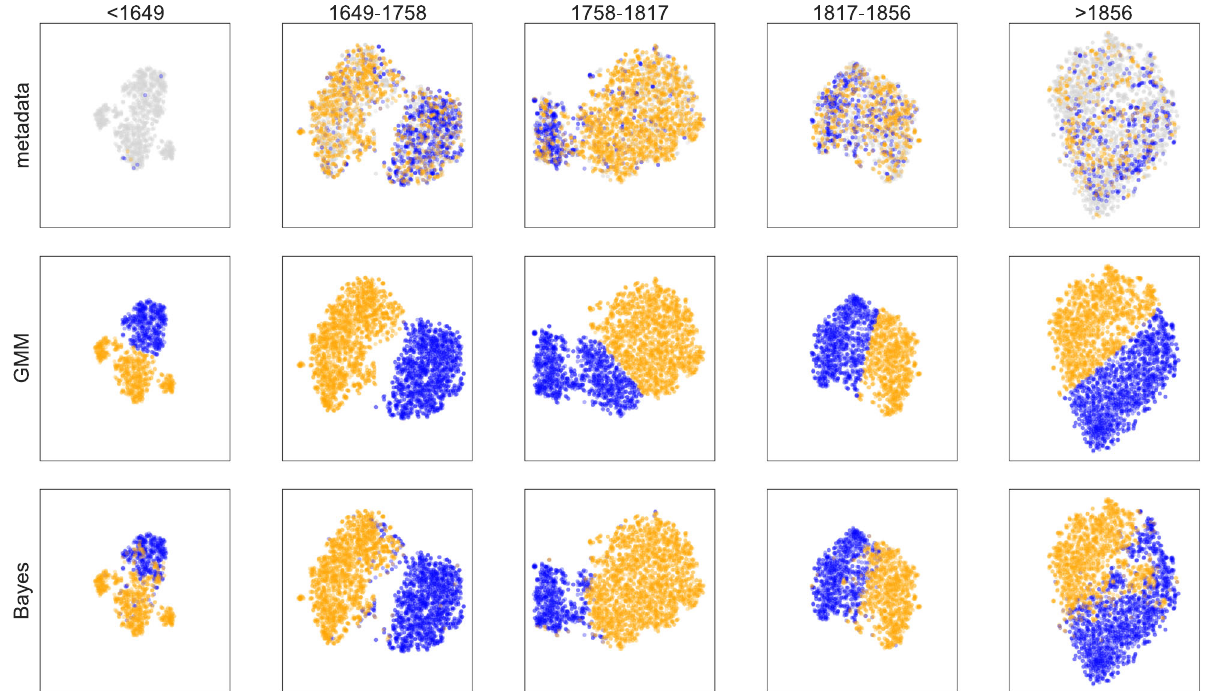
Fig. 4 Dimensionality reduction of the mode space M using t -distributed stochastic neighbor embedding ( t -SNE; Van Der Maaten and Hinton, 2008). Each data point corresponds to a piece in the dataset. The columns represent the different time periods. The colors orange and blue correspond to major and minor, respectively. Gray corresponds to missing mode labels in the metadata. The coloring in the top row shows the key labels from the metadata. It approximately corresponds to the clusters in the reduced space. The middle row is colored according to the classi fi cation of a Gaussian mixture model (GMM) in the reduced space. The bottom row is colored according to the unsupervised Bayesian mode classi fi er which successfully learns the concepts of major and minor purely data-driven from the pitch-class counts of the pieces. In particular, the labeling of the Bayesian model corresponds to the geometrical positions of the pieces without using these distances for classi fi cation. This indicates that transpositional invariance is a characterizing property of the concept of